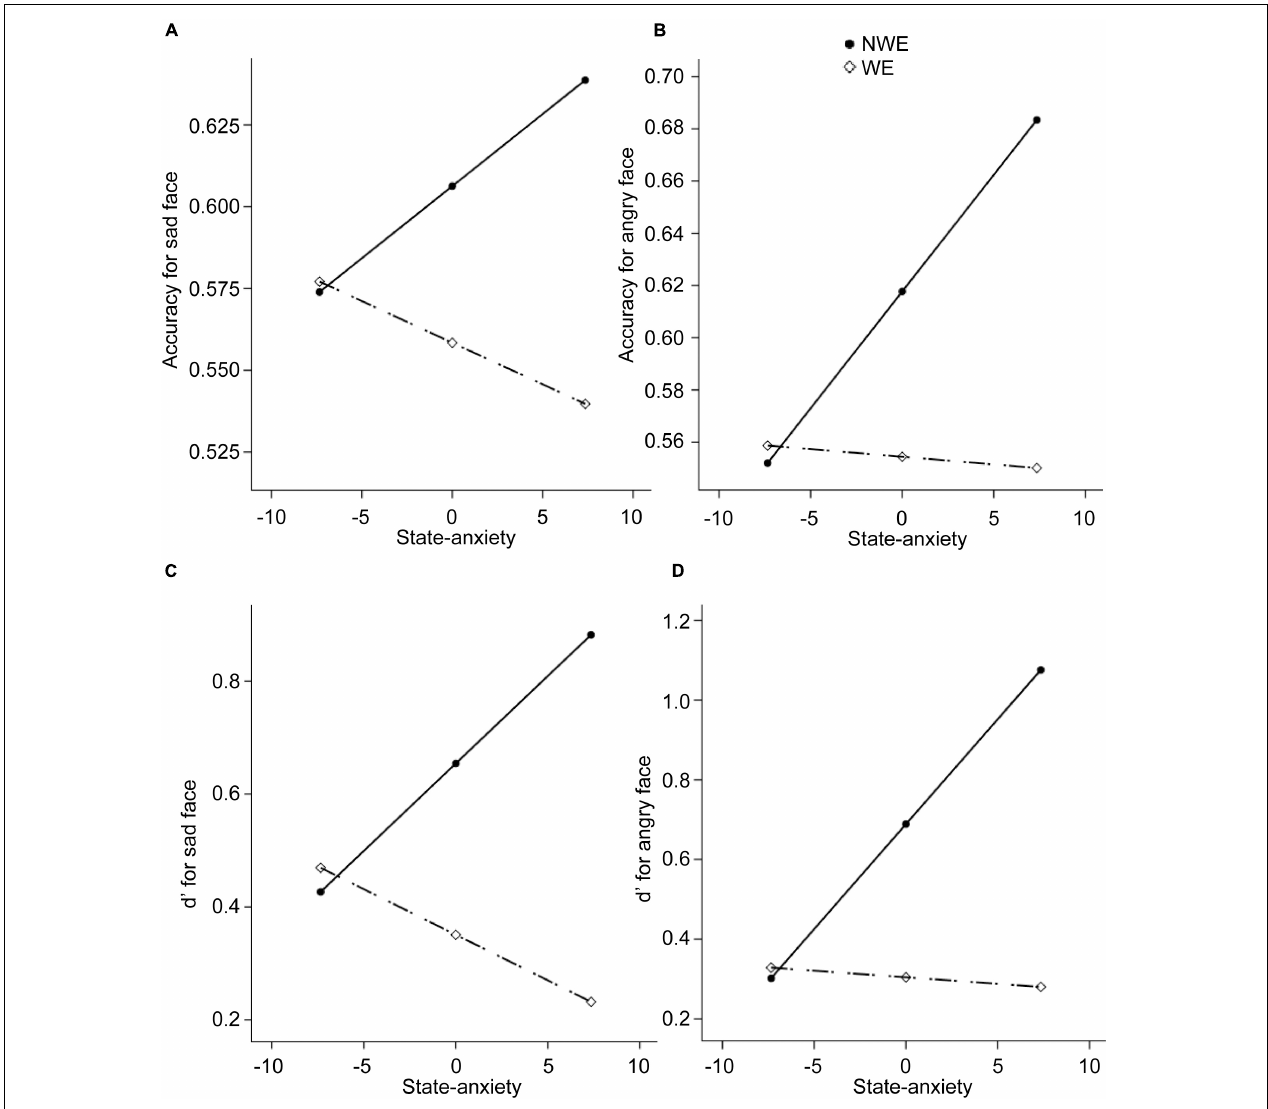
FIGURE 3 | The moderation effect of state anxiety on the relationship between widowhood and the performance in the DMTS experiment. The dependent variables are the mnemonic accuracy for sad faces, the mnemonic accuracy for angry faces, d (cid:48) for sad faces, and d (cid:48) for angry faces, respectively, for (A–D) . NWE, non-widowed elderly; WE, widowed